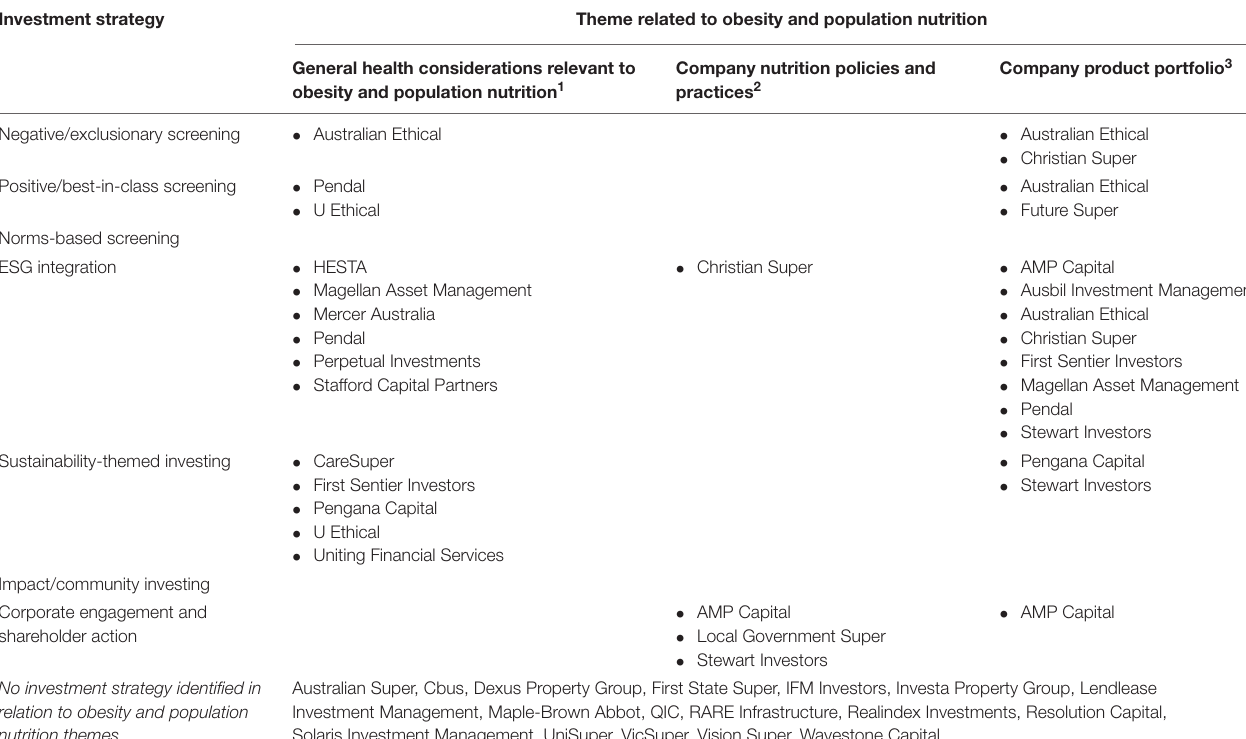
TABLE 3 | Investment strategies of asset managers and superannuation funds and the obesity/population nutrition theme to which they relate. Investment